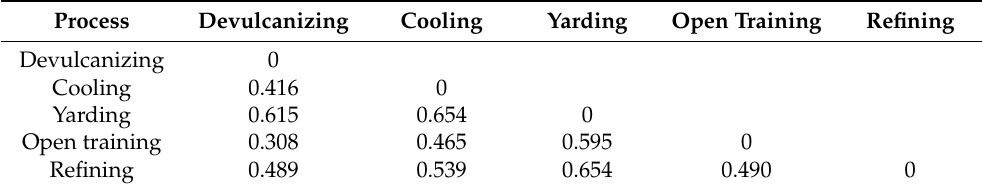
Table 4. Divergence coefficients between the VOCs source profiles in each process. Process Devulcanizing Cooling Yarding Open Training Refining Devulcanizing